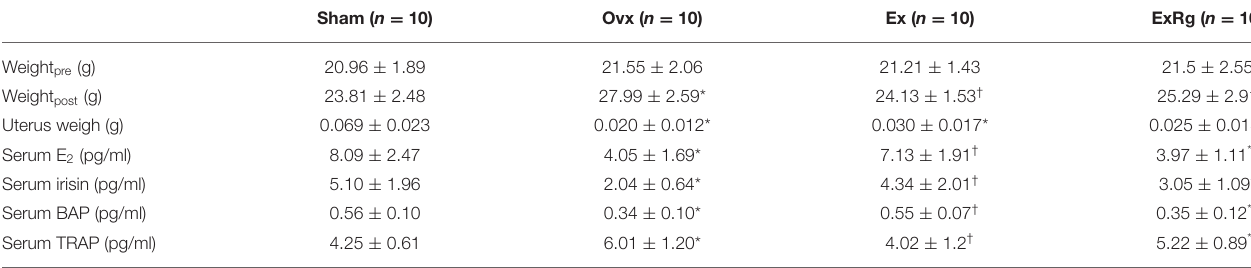
TABLE 1 | Physical and serum parameters of mice between groups.